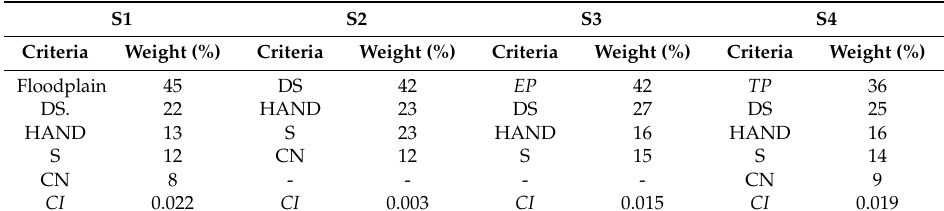
Table 10. Weights of flood hazard criteria for each scenario.